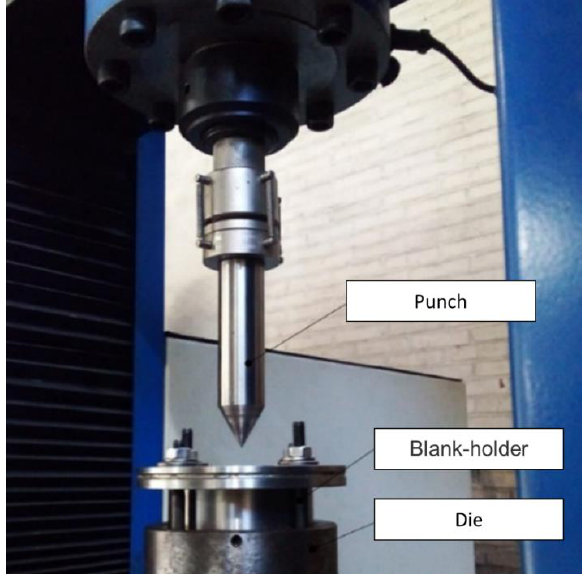
Figure 7. Hole expansion test (Reproduced with permission from Rosiak, A. et al.; published by 41st SENAFOR, 2022 [29]).